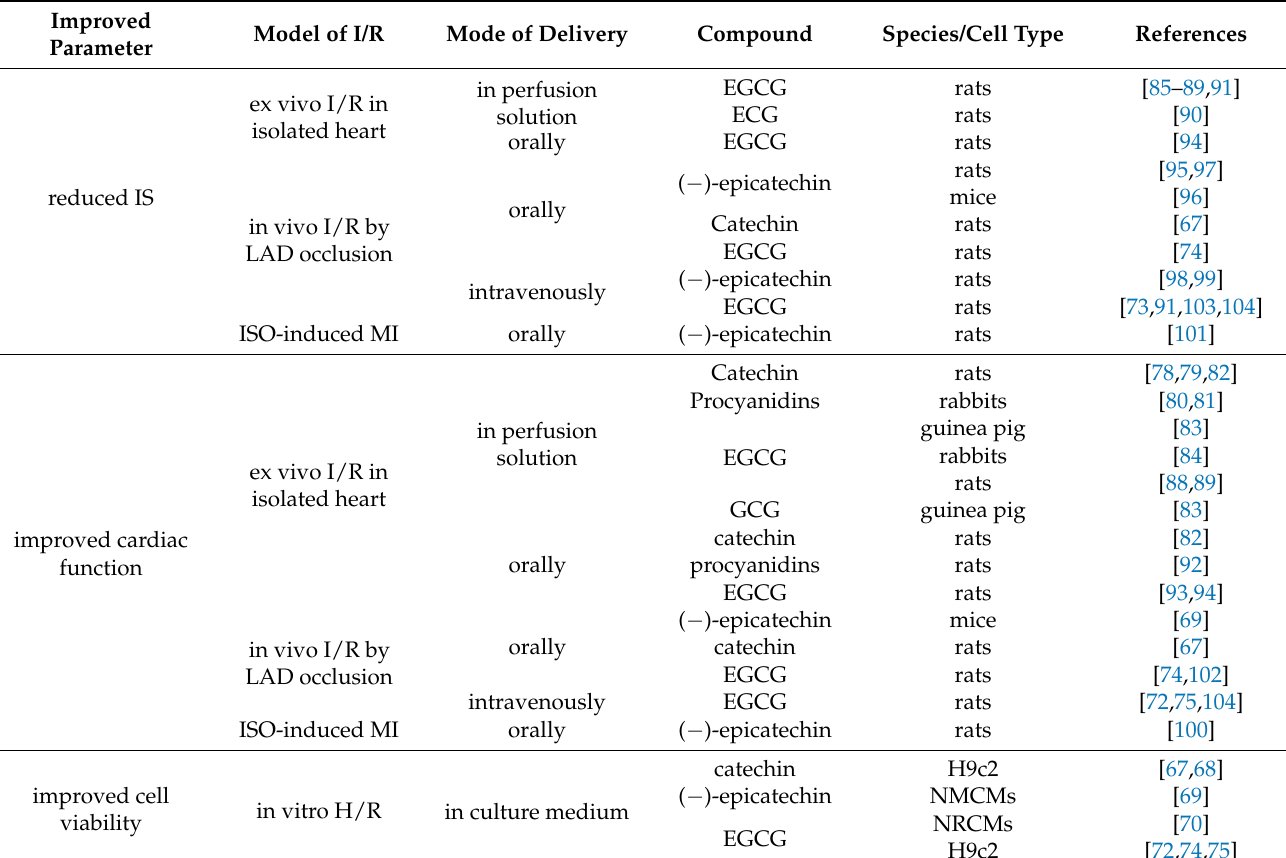
Table 1. Effects of catechins on cardiac function, cell viability, and size of infarction in pre-clinical models of